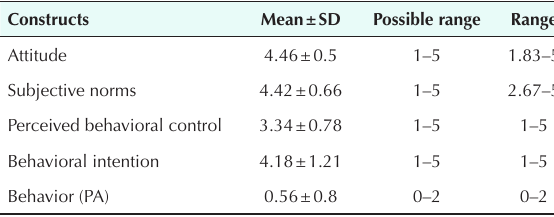
Table 2. The mean scores of the TPB constructs and the PA